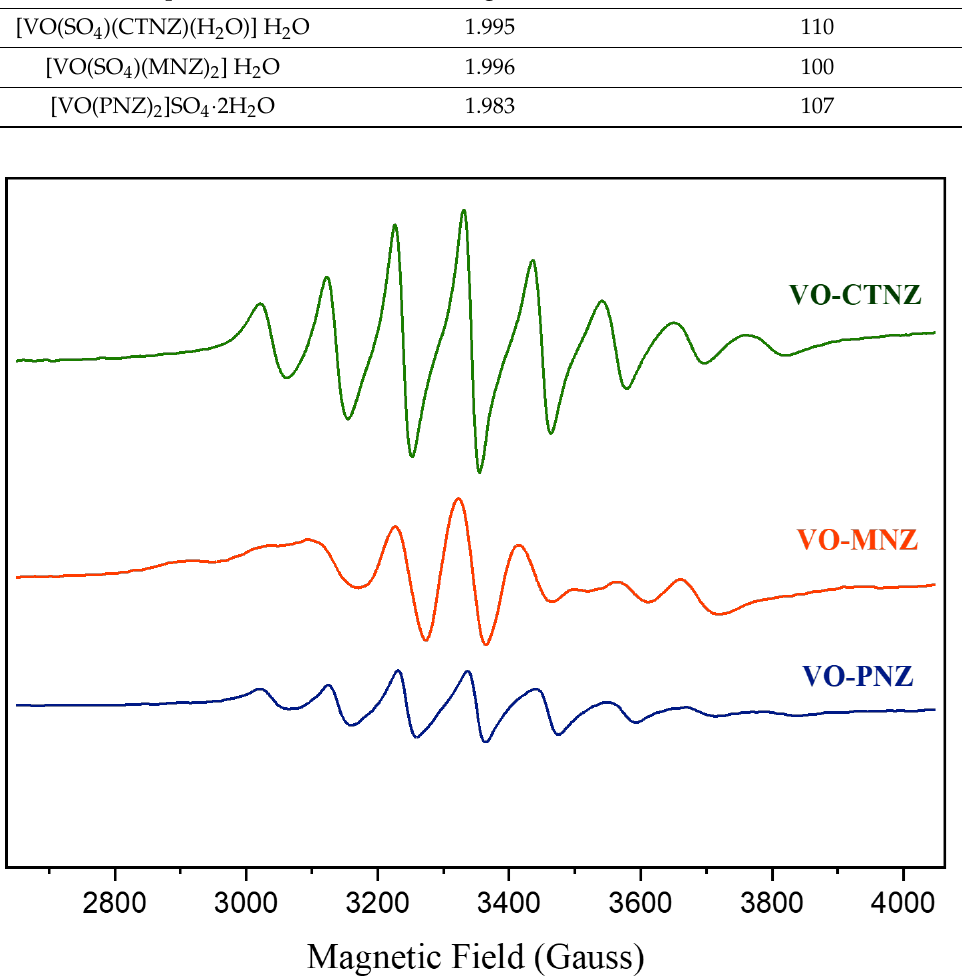
Figure 6. EPR spectra of oxidovanadium(IV) complexes.